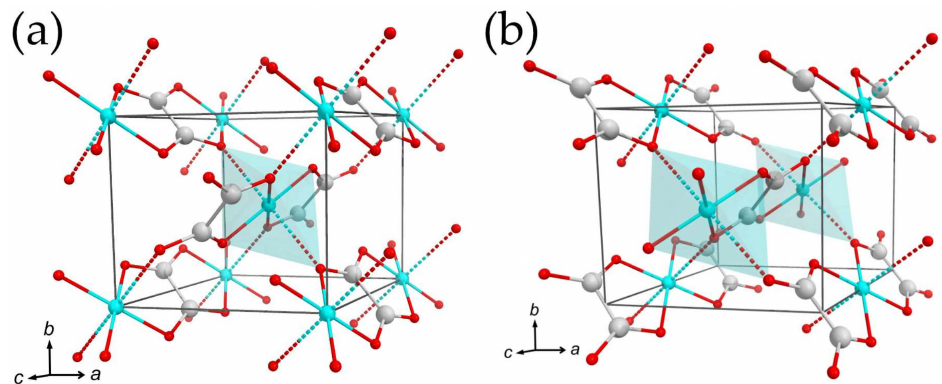
Figure 7. The crystal structures of the MC2a model ( a ) and MC2b model ( b ). Cu atoms at the center of the unit cells are showed within CuO 6 octahedra. Legend: same as that in Figure